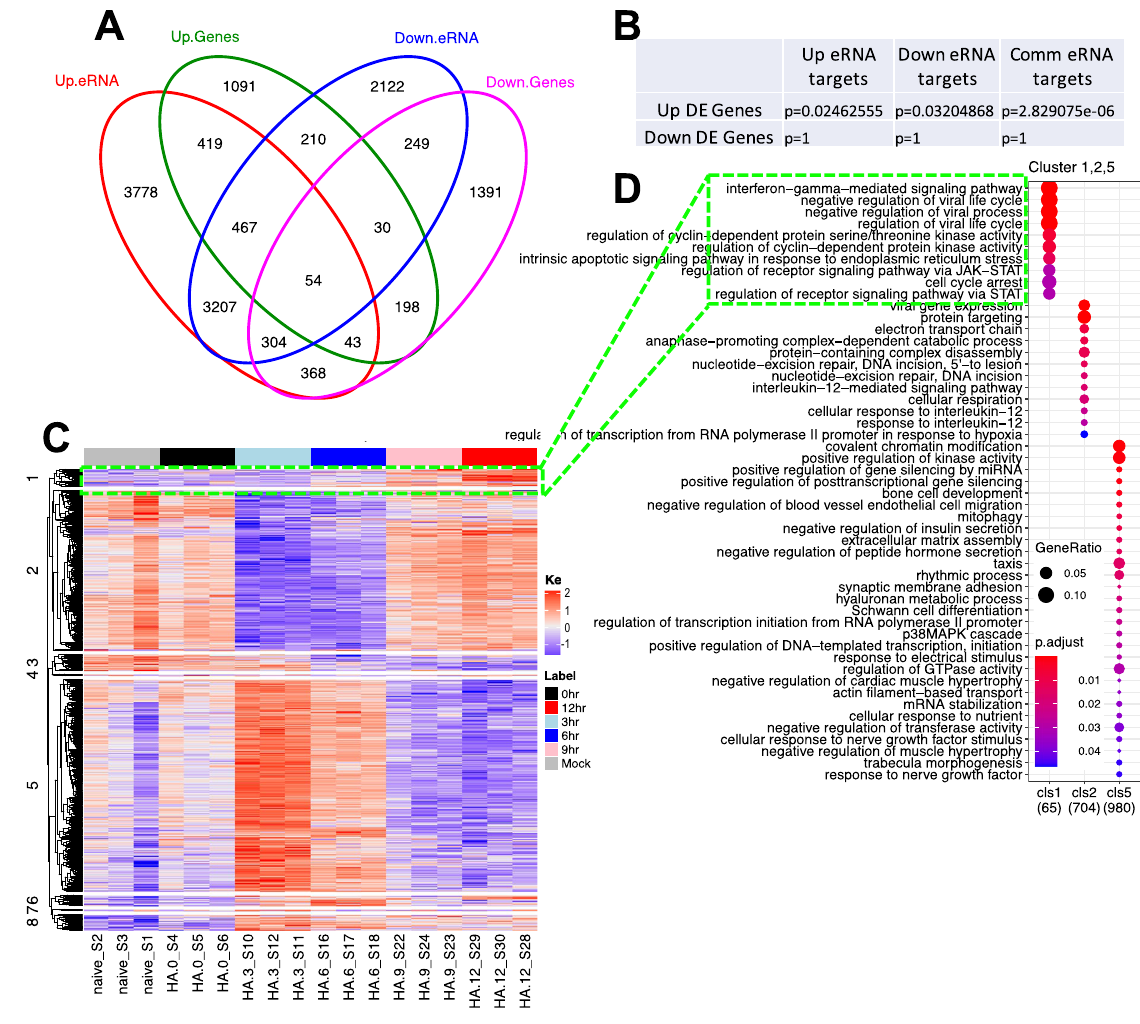
Figure 4. The DE TE associated eRNA targets are significantly enriched in up regulated DE genes. ( A ) Venn diagram shows the overlap between up or down DE genes and up or down DE TE related eRNA targets. The hypergeometric tests were performed, and the results are presented in B. ( B ) Hypergeometric test shows DE TE related eRNA targets are significantly enriched in the upregulated DE genes, e.g. the subset of common eRNA targets (intersection marked 3207,467,304,54) overlaps the subset of upregulated genes (intersection marked 467,54). ( C ) Hierarchical clustering analysis for the overlapped 2144 DE genes. ( D ) GO term enrichment analysis results demonstrate the IFN and virus life cycle pathways in the cluster